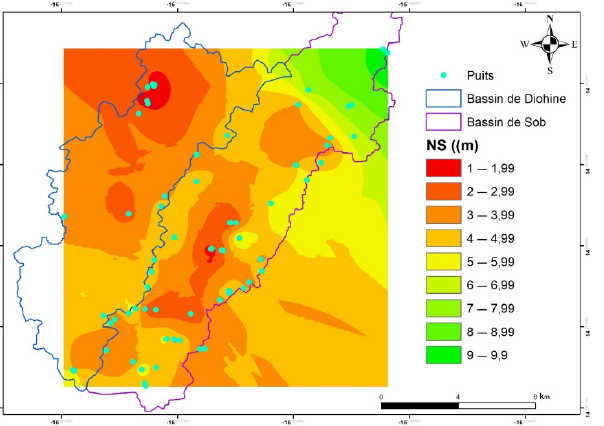
Figure 7. Percentage of water salinity distribution in wells dis- tributed in Sob and Diohine watersheds, one-shot measurements campaign in June